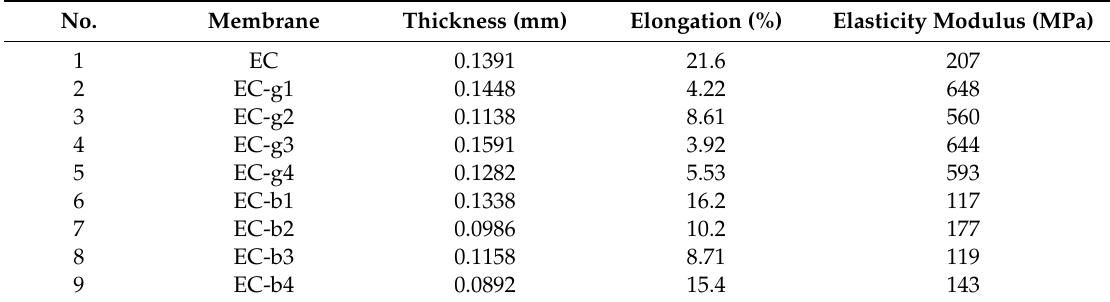
Table 3. Mechanical properties of the membranes of EC modified with ionic liquids